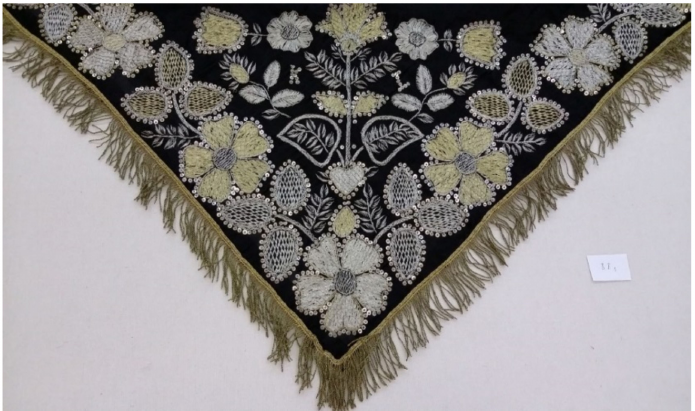
Figure 2. Scarf from the Ethnographic Museum Zagreb, work of Ðakovo region, end of the 19th to the middle of the 20th